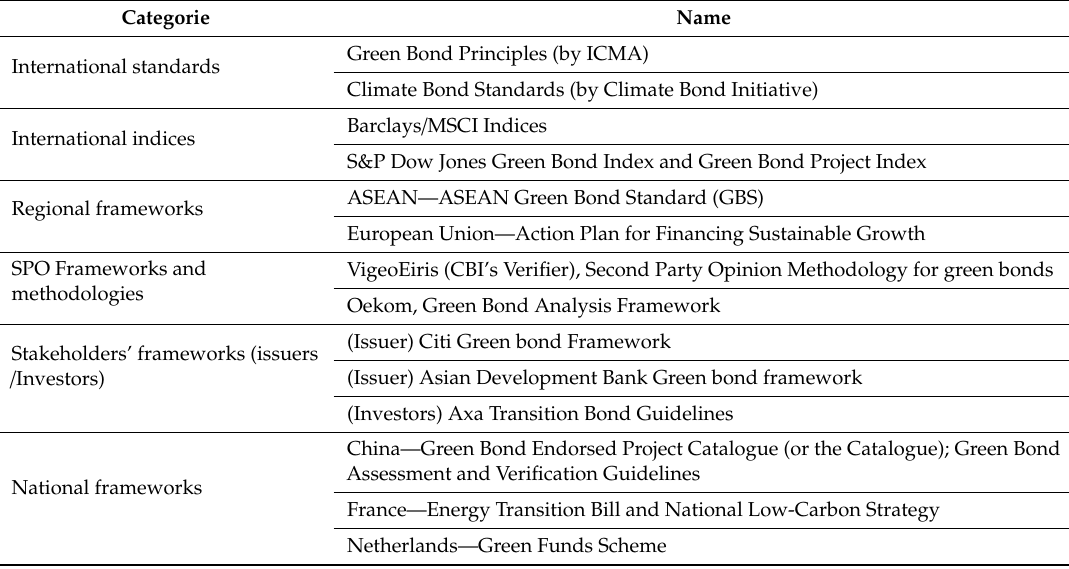
Table 2. Selected existing standards, principles, indices, and frameworks.